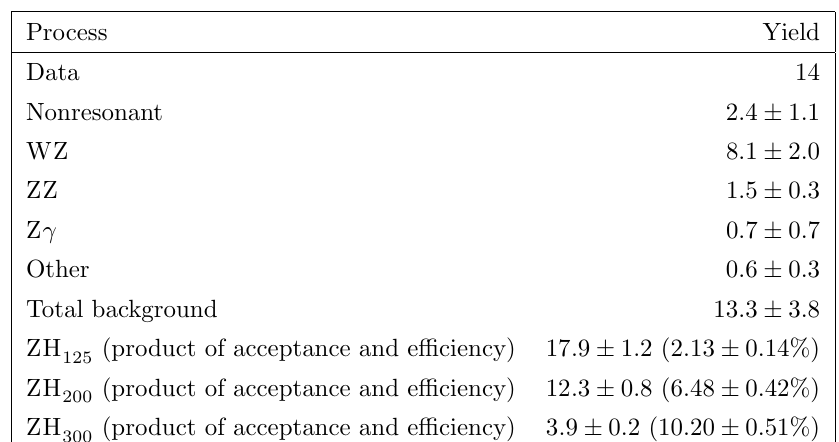
Table 2 . Observed yields, background estimates after the (cid:12)t to data, and signal predictions after the event selection. The signal size corresponds to 0 : 1 (cid:27) combined statistical and systematic uncertainties are reported. The values in parentheses for the signal processes correspond to the products of acceptance and selection e(cid:14)ciency for Z ! ‘‘